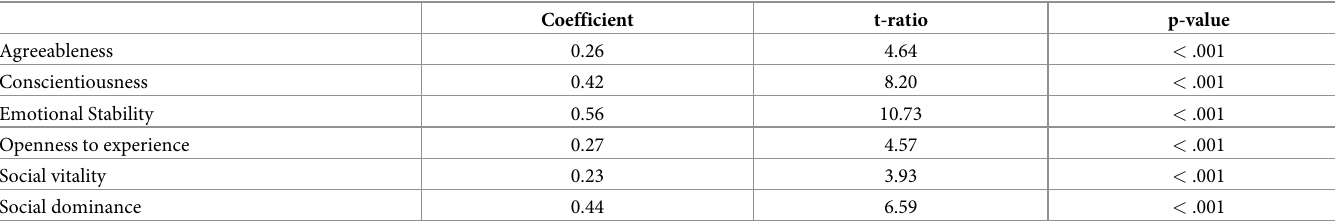
Table 5. Relationship between Self-ratings and the ratings for people in general for personality traits over the